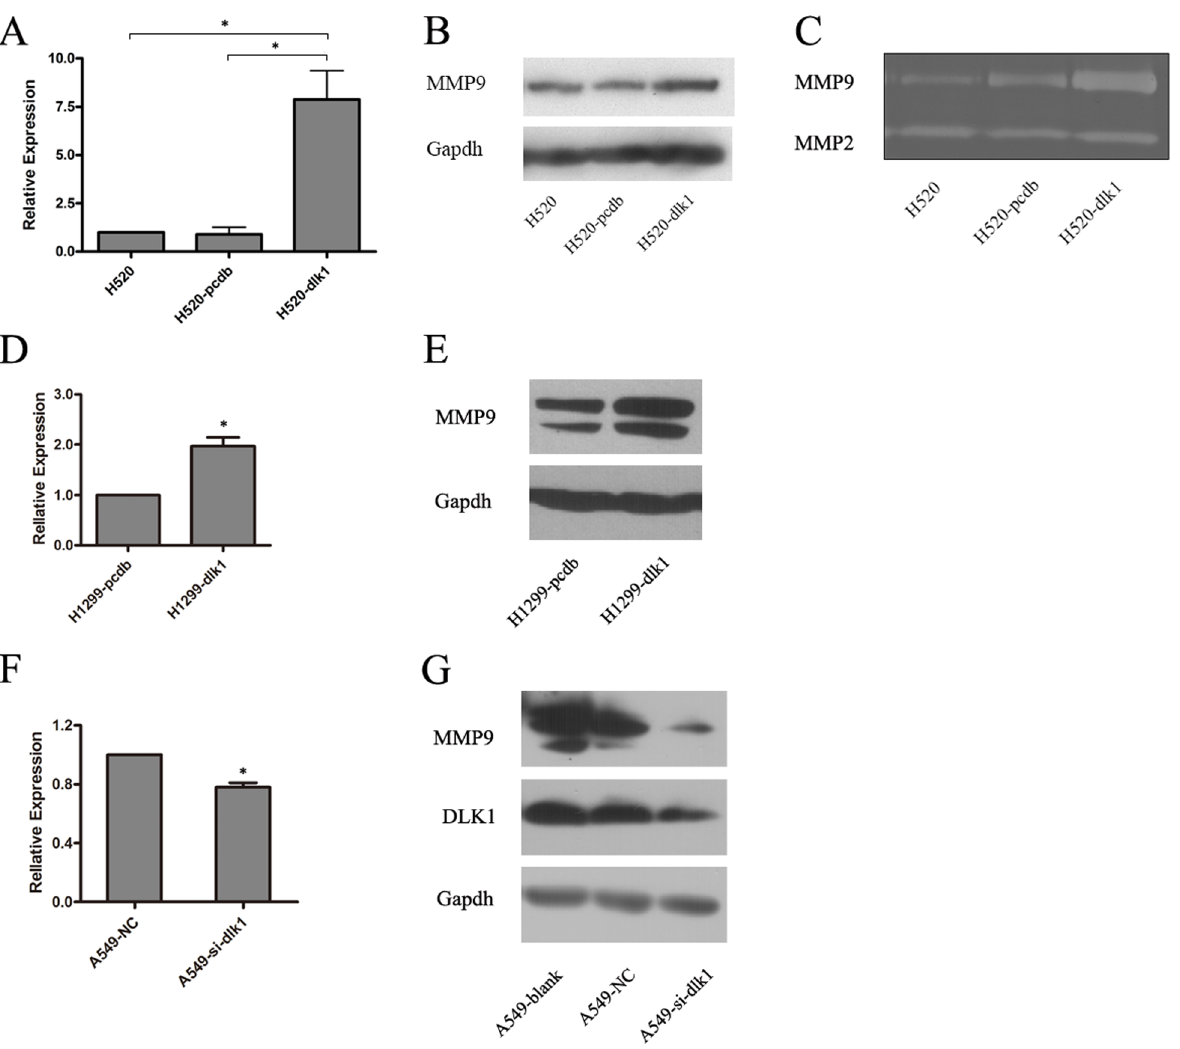
Figure 2. Effect of DLK1 on the expression and activity of MMP9 in human lung cancer cell lines. A, a histogram for the relative mRNA expression of MMP9 in H520 cells transfected with DLK1 (H520-dlk1) or null vector (H520-pcdb) detected by real-time PCR analysis. The expression level of MMP9 in the blank H520 cells was used as a control and set to 1. B, the protein expression of MMP9 in H520-dlk1, H520-pcdb and H520 cells evaluated by Western blotting analysis. C, gelatin zymography showing the activity of secreted MMP9 and MMP2 in H520-dlk1, H520-pcdb and H520 cells. D, real-time PCR analysis of the relative mRNA expression of MMP9 in H1299 cells transfected with DLK1 (H1299-dlk1) or null vector (H1299- pcdb) shown in a histogram. E, Western blotting showing the protein expression of MMP9 in H1299-dlk1 and H1299-pcdb cells. F, a histogram showing the relative mRNA expression of MMP9 in DLK1 siRNA (A549-si-dlk1) or null control siRNA (A549-NC) transfected A549 cells evaluated by real- time PCR analysis. G, the protein expression of MMP9 in A549-si-dlk1, A549-NC and blank A549 cells detected by Western blotting. All of